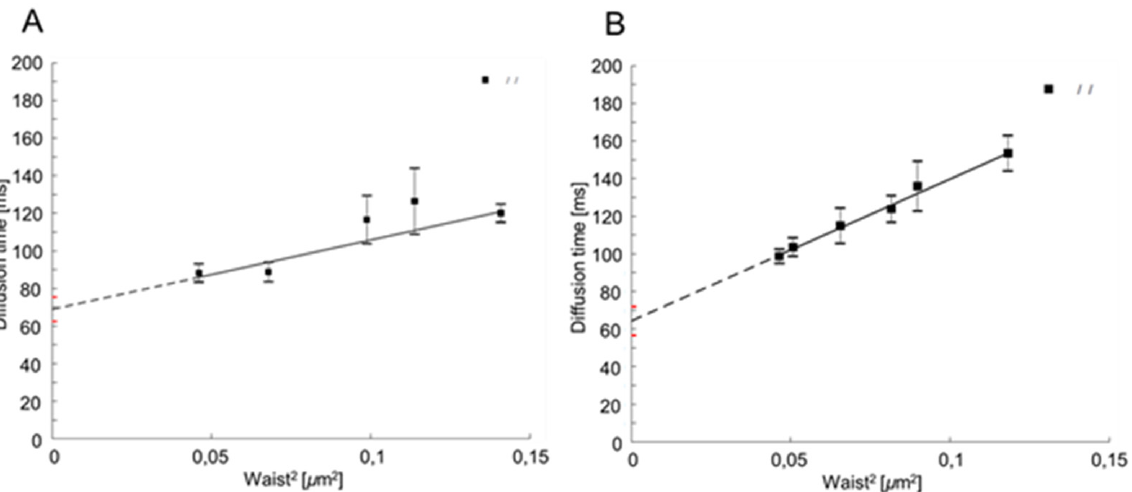
Figure 1. Diffusion time of Cdr1p-GFP, determined in C. albicans CAF2-1 ( A ) and erg11 ∆ / ∆ ( B ) strains after 24 h of culture in YPD medium. Diffusion time was measured using svFCS microscopy and then analyzed and calculated with IGOR and DiffusionLawsCIML software.